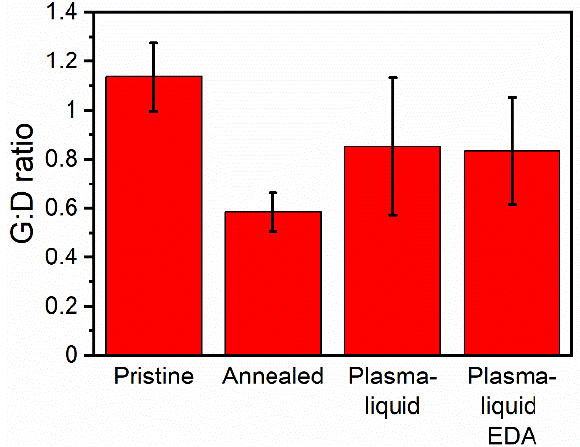
Figure 5. Summary of the G-band to D-band area ratios determined by Raman spectroscopy.